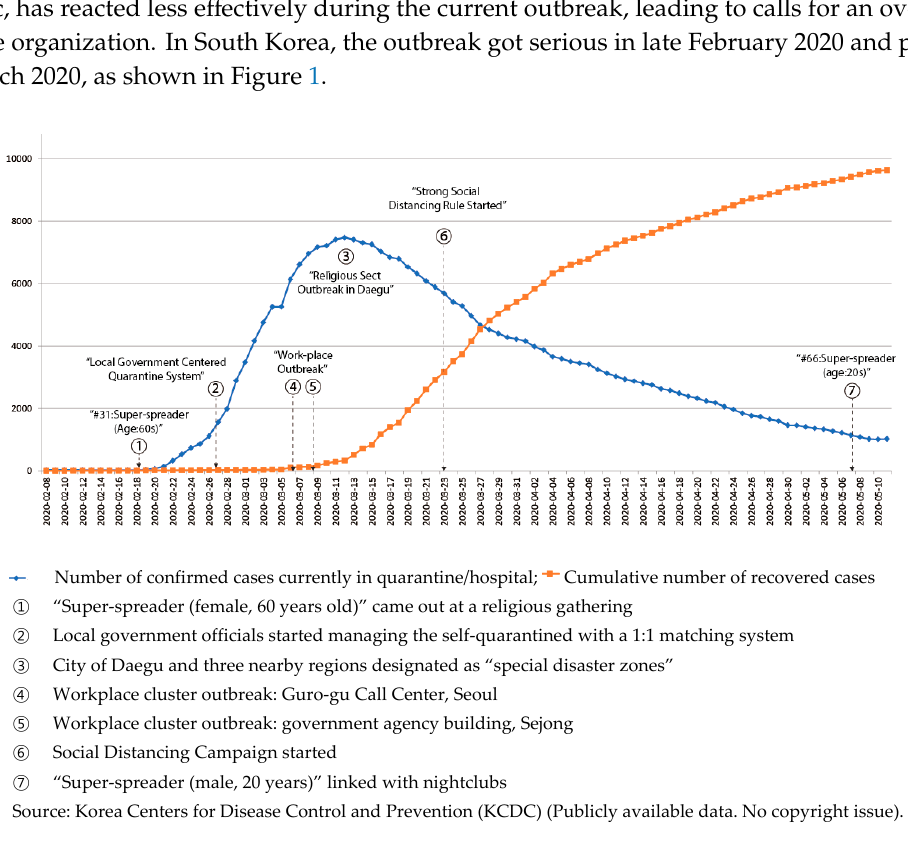
Figure 1. Number of quarantined and recovered patients.